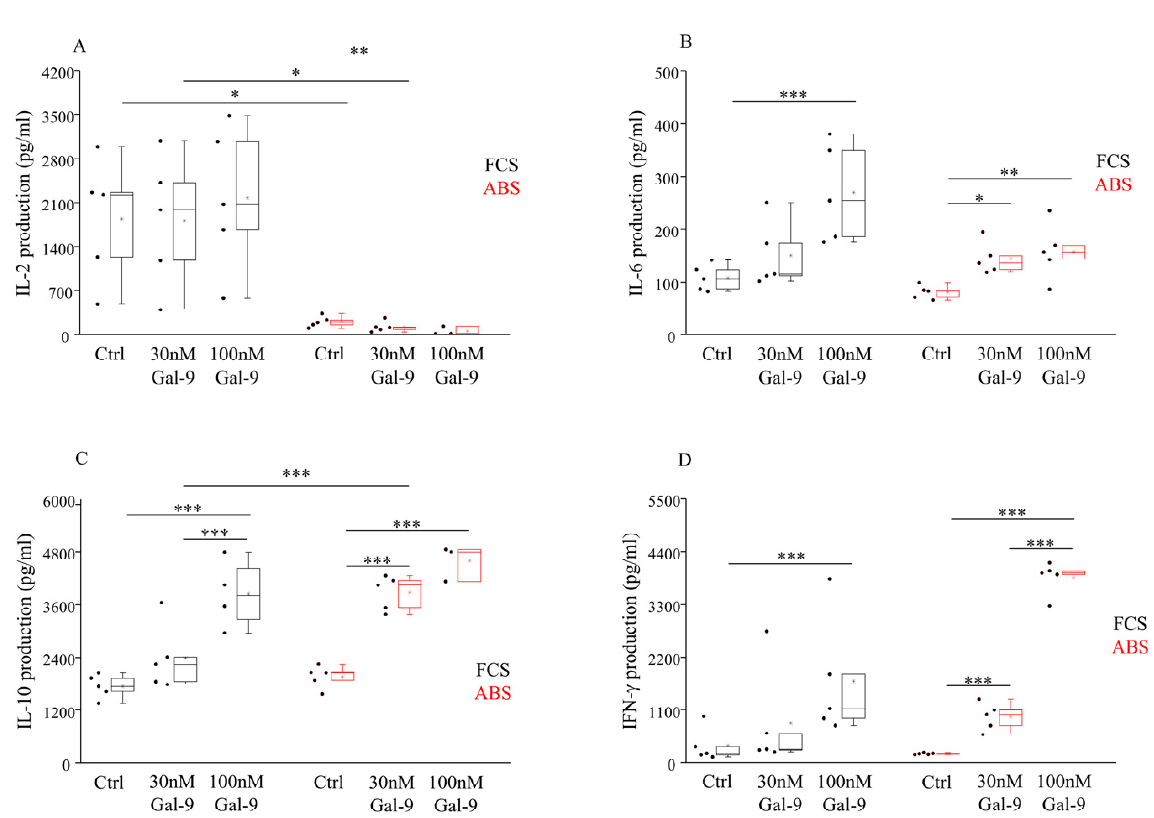
Figure 5. Different cytokine production by NK-92MI cell line cultured in medium supplemented with FCS or human ABS and after recombinant Gal-9 treatment. L-2 ( A ), IL-6 ( B ), IL-10 ( C ), and IFN- γ ( D ) cytokine production by NK-92MI cells, following addition of 30 and 100 nM Gal-9, cultured in medium supplemented with 10% FCS or 10% human ABS. The solid bars represent medians of 10 determinations, the boxes indicate the interquartile ranges, and the lines show the most extreme observations. Differences were considered statistically significant for p -values * < 0.05; ** < 0.03; *** <